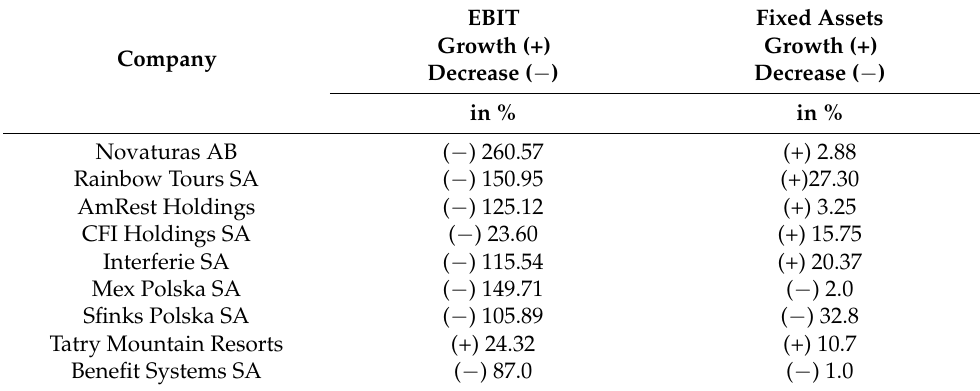
Table 3. Dynamics of EBIT and fixed assets for the audited companies (First half of 2019–first half of